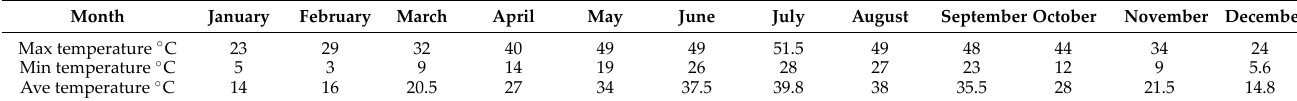
Table 2. Minimum and maximum air temperature in Celsius [80].